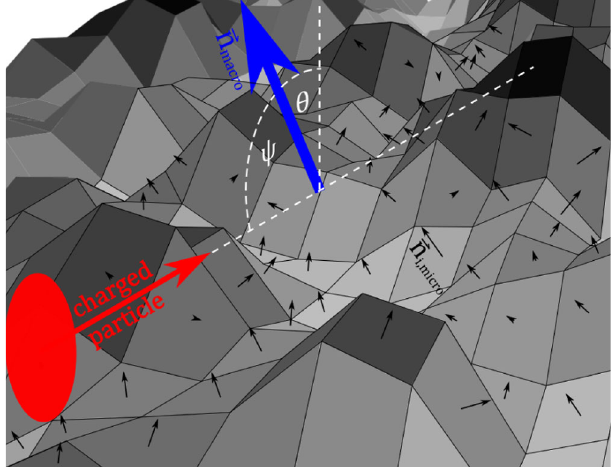
FIG. 3. Schematic representation of a target with a rough surface hit by a charged particle under shallow incidence. Given the depicted piecewise planar microsurfaces (with individual normals ⃗ n i; ) are bigger than the effective transversal extent of micro ¼ βγλ in vacuum), they can be the incident electric field ( r eff thought as individual OTR sources.